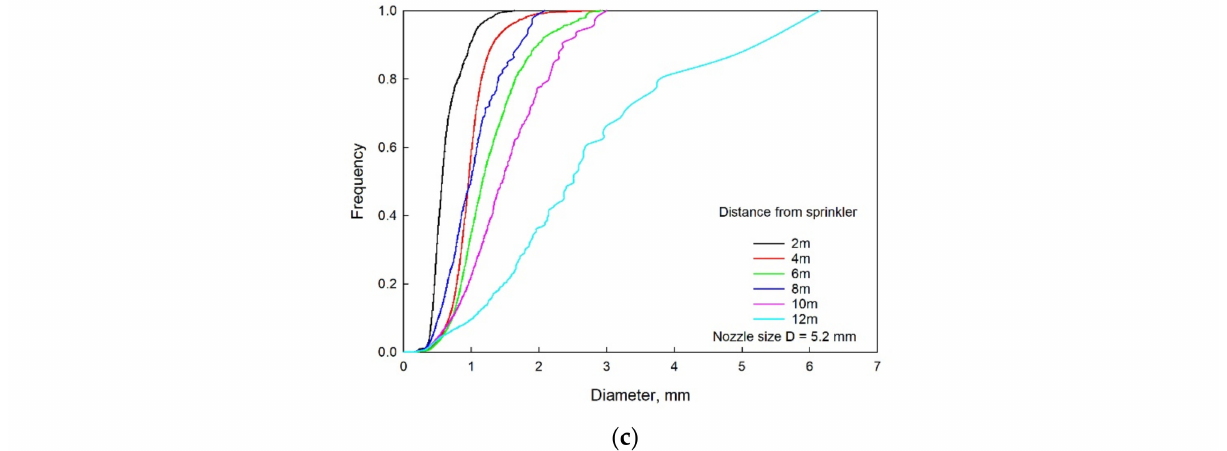
Figure 8. Droplet cumulative volume of the sprinklers with nozzle sizes of ( a ) D = 4.4 mm, ( b ) D = 4.8 mm and ( c ) D = 5.2 mm under 200 kPa of